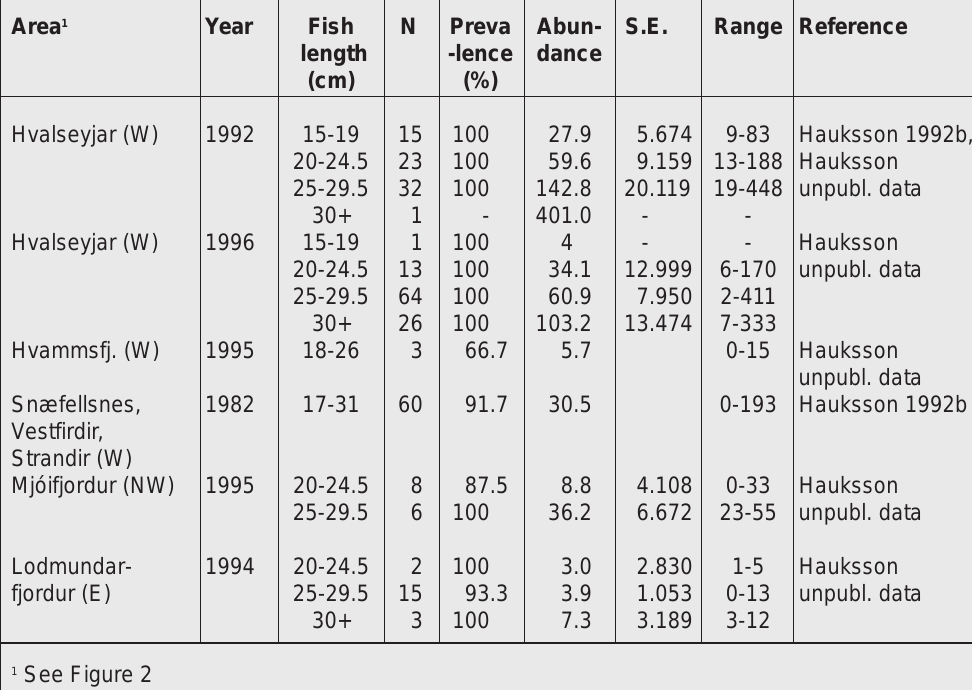
Table 3. Prevalence and abundance of sealworm ( Pseudoterranova decipiens ) in bull rout ( Myoxocephalus scorpius ) at various locations in shallow waters around Iceland in 1982-96 (Hauksson unpubl.